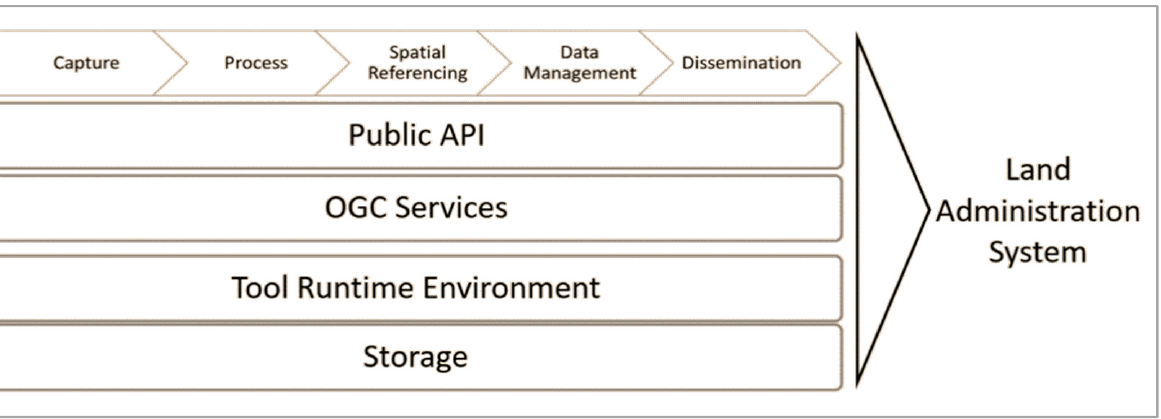
Figure 3. Abstract workflow of PaS.